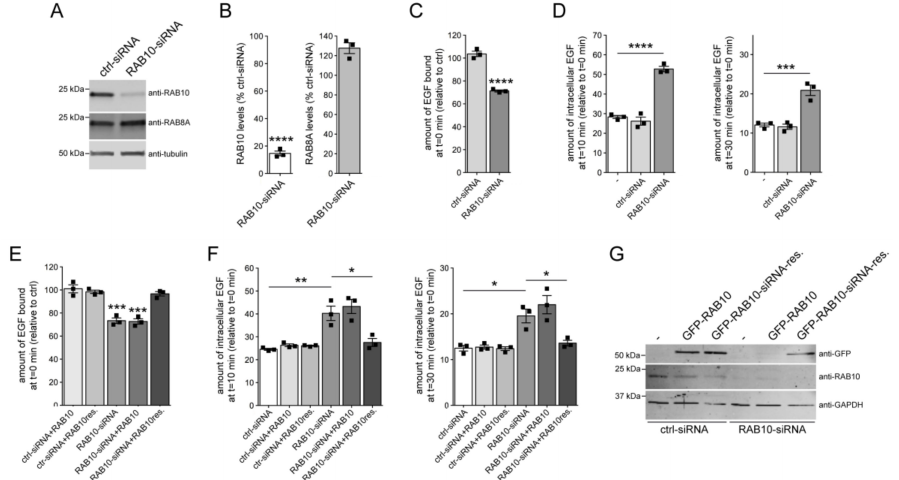
Figure 2. Knockdown of RAB10 mimics the EGF tra ffi cking deficits observed upon G2019S LRRK2 expression. ( A ) HeLa cells were either transfected with ctrl-siRNA or RAB10-siRNA, and cell extracts were analyzed by Western blotting for RAB10 protein levels, RAB8A protein levels, or tubulin as loading control. ( B ) Quantification of RAB10 and RAB8A protein levels in the presence of RAB10-siRNA, normalized to the levels in the presence of ctrl-siRNA. Bars represent mean ± s.e.m. (N = 3 independent experiments; **** p < 0.001). ( C ) Cells were either left untreated (-), or treated with ctrl-siRNA or RAB10-siRNA, and the amount of surface-bound fluorescent EGF was quantified. N = 3 independent experiments; **** p < 0.001. ( D ) Cells were either untreated (-), or treated with ctrl-siRNA or RAB10-siRNA, and internalized fluorescent EGF was quantified at 10 min (left) and 30 min (right). N = 3 independent experiments; *** p < 0.005; **** p < 0.001. ( E ) Cells were either transfected with ctrl-siRNA or RAB10-siRNA in the absence or presence of wildtype or siRNA-resistant GFP-tagged RAB10 as indicated, and the amount of surface-bound fluorescent EGF was quantified. N = 3 independent experiments. *** p < 0.005. ( F ) Cells were either transfected with ctrl-siRNA or RAB10-siRNA in the absence or presence of wildtype or siRNA-resistant GFP-RAB10, and internalized fluorescent Alexa555-EGF quantified upon 10 min (left) or 30 min (right) of internalization. N = 3 independent experiments. * p < 0.05; ** p < 0.01. ( G ) Cells were either transfected with ctrl-siRNA or RAB10-siRNA, and with either wildtype or siRNA-resistant GFP-tagged RAB10 as indicated, and cell extracts (30 µ g) analyzed by Western blotting for GFP-RAB10 levels, endogenous RAB10 levels, and GAPDH as loading